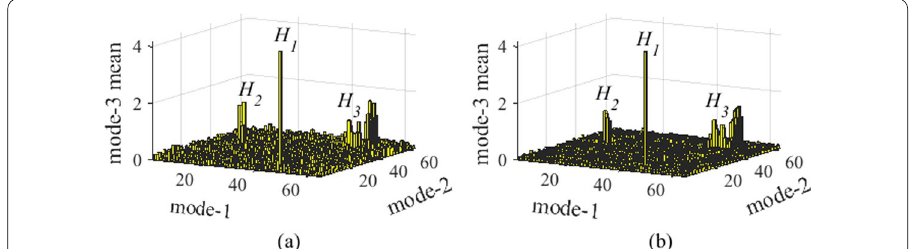
Fig. 2 3D bar plots for three hot spots H 1 , H 2 , H 3 . a Data tensor D . b Computed tensor M